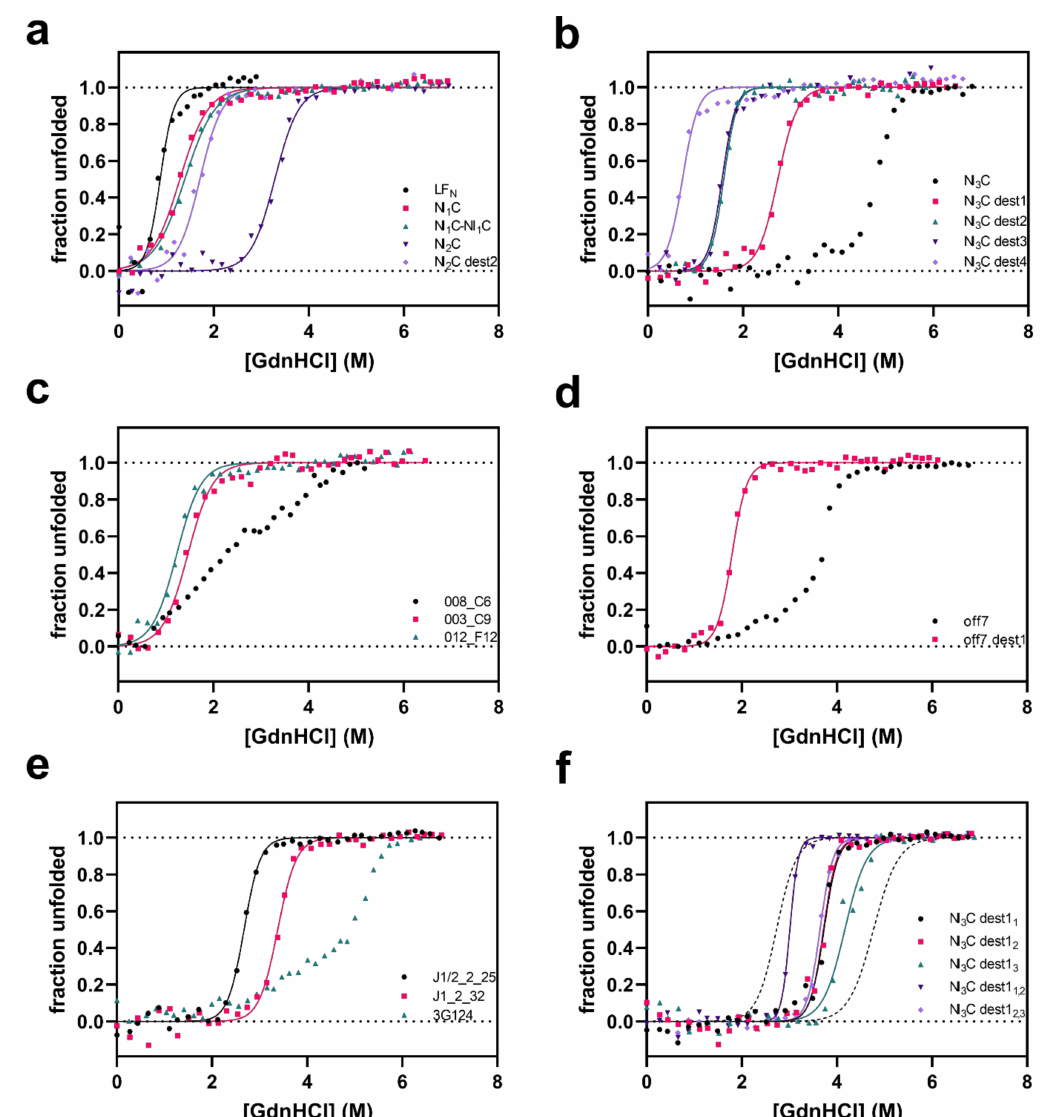
Figure 2. GdnHCl-induced equilibrium unfolding of various cargo DARPins in PBS (pH 7.4) at 20 ◦ C, analyzed by CD spectroscopy. Curves represent a fit to Equation (1). ( a ) LF N and the consensus DARPins NI 1 C, NI 1 C-NI 1 C, NI 2 C, and NI 2 C dest2; ( b ) NI 3 C consensus DARPin and mutated variants of it (NI 3 C dest1–4); ( c ) target-selected LoopDARPins; ( d ) MBP-binding DARPin off7 and a destabilized off7 variant; ( e ) JNK-binding DARPins and eGFP-binding DARPin 3G124; ( f ) NI 3 C dest1 variants with repeat-specific mutations: dashed lines represent NI 3 C with no mutations (right) and NI 3 C dest1 with all mutations (left). Destabilizing mutations (dest1–4) have been described before [6], and their location is listed in Table